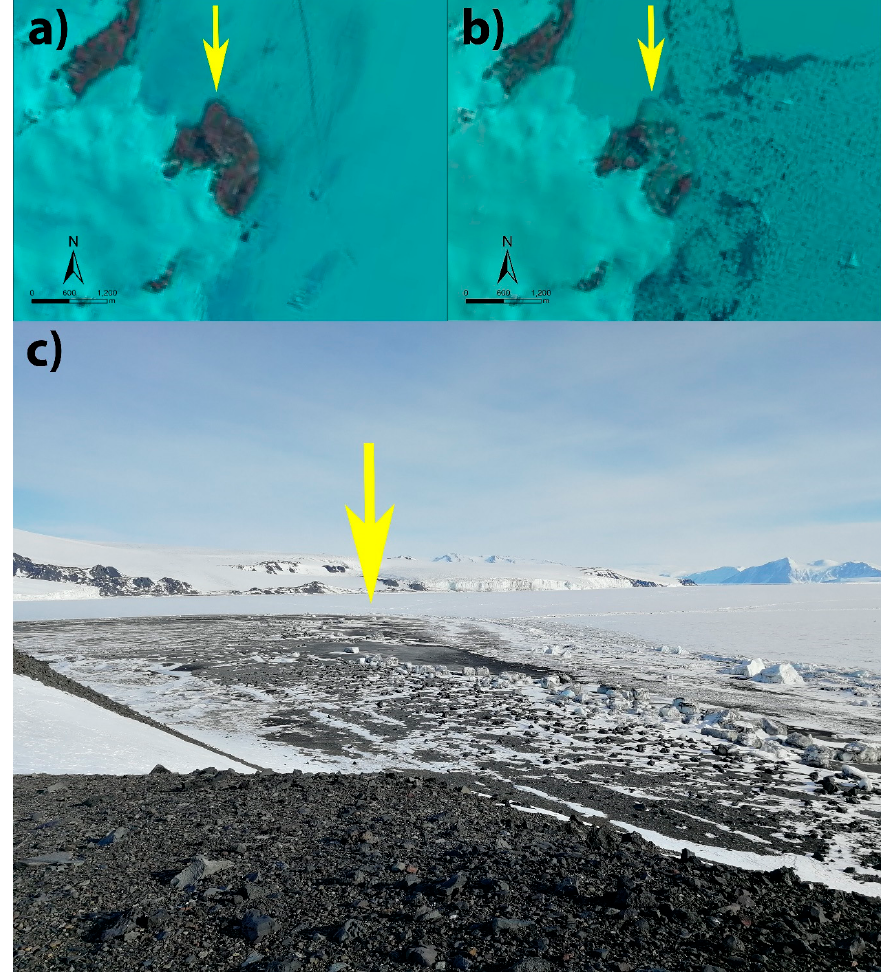
Figure 5. Temporal variation of the sea ice cover offshore and on the shore. Yellow arrows indicate the northernmost sector of the beach as reference in the Landsat images ( a ) 03/02/2019 and ( b ) 17/02/2019 and the ground view taken during the campaign ( c ) 11-11-2019.